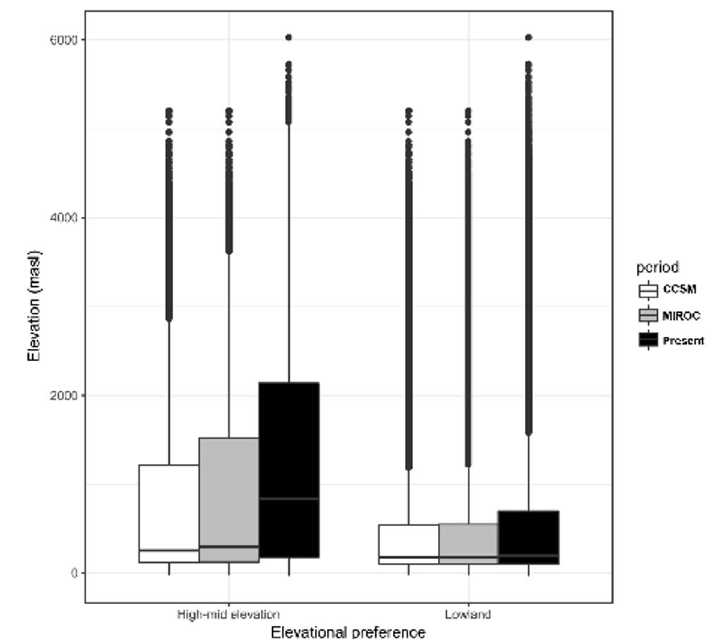
Figure 3. Elevational ranges predicted for species in each of the two elevational bands, high- to mid-elevation species (n=7) versus low elevation species (n=7), in two time periods, the present and the last glacial maximum (LGM). Predicted LGM climate conditions were obtained from two general circulation models: the Community Climate System Model (CCSM) and the Model for Interdisciplinary Research on Climate (MIROC). To obtain elevation values, we generated 10,000 random points in the whole study area, and elevation values were extracted from values for points in suitable habitat areas (binary prediction of 1) from an altitude layer obtained from the WorldClim database (Hijmans et al. 2005). For both elevational bands there were significant differences in elevation between time periods, irrespective of the LGM projection used (df=2, P -value < 2.2 × 10 -16, for both high and low elevation species with χ 2 = 9105.3 and χ 2 = 1614.8 respectively). masl = meters above sea